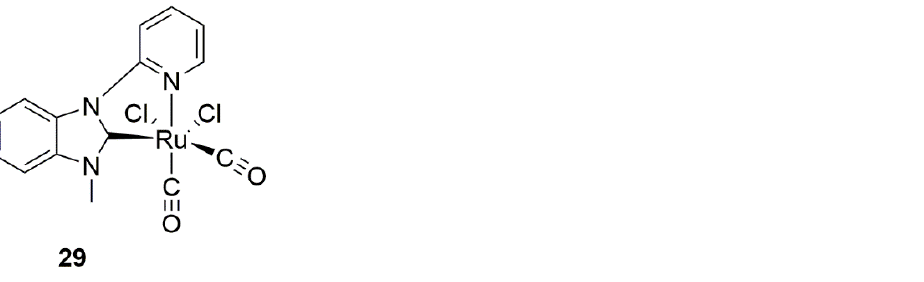
Figure 3. Ru(II) carbonyl complexes investigated in transfer hydrogenation reaction